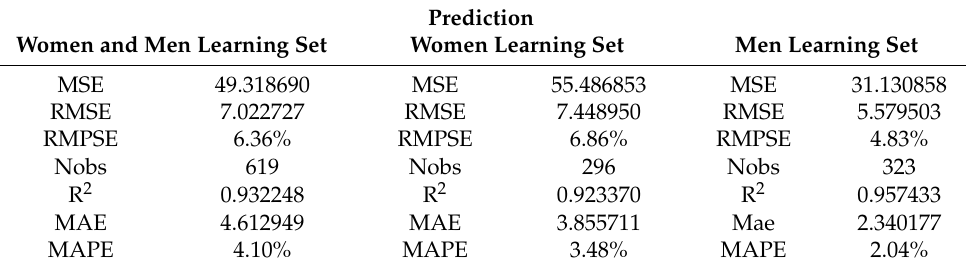
Table 7. Parameters of the generated models—prediction of age assessment.